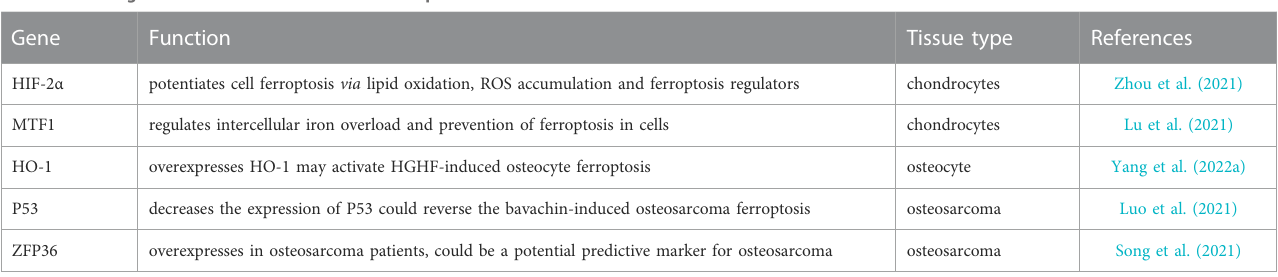
TABLE 1 List of genes in different tissue and their respective function. Gene